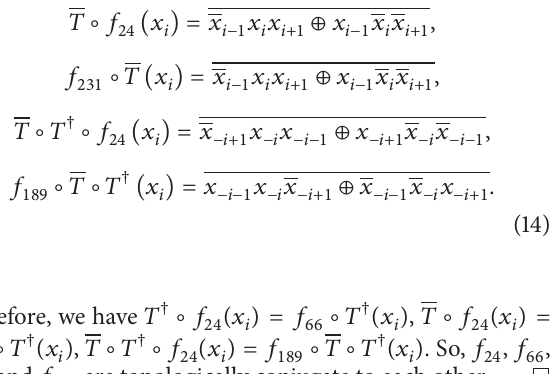
𝑇 ∘ 𝑓 (𝑥 ) = 𝑥 𝑥 𝑥 ⊕ 𝑥 𝑥 𝑥 24 𝑖 𝑖−1 𝑖 𝑖+1 𝑖−1 𝑖 𝑖+1